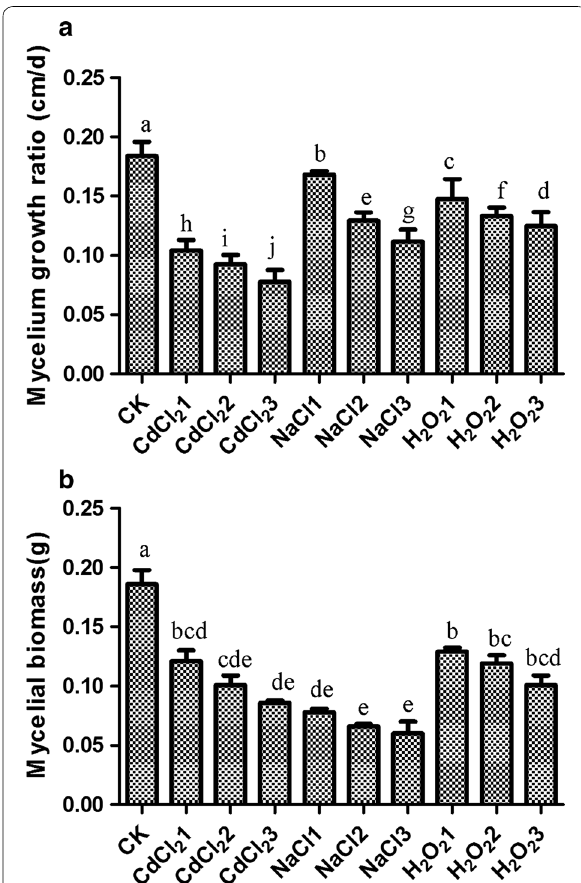
Fig. 1 Effects of different concentrations of CdCl 2 , NaCl and H 2 O 2 on mycelial growth and biomass of Hypsizygus marmoreus . Mycelia were incubated with different concentrations of CdCl 2 , NaCl and H 2 O 2 . The mycelial growth was detected on PDA medium after 10 days of incubation ( a ), and the mycelial biomass was detected on PDB medium after 10 days of incubation ( b ). Data are mean independent experiments. Bars with different letters are significantly different at P < 0.05 according to Duncan’s multiple range